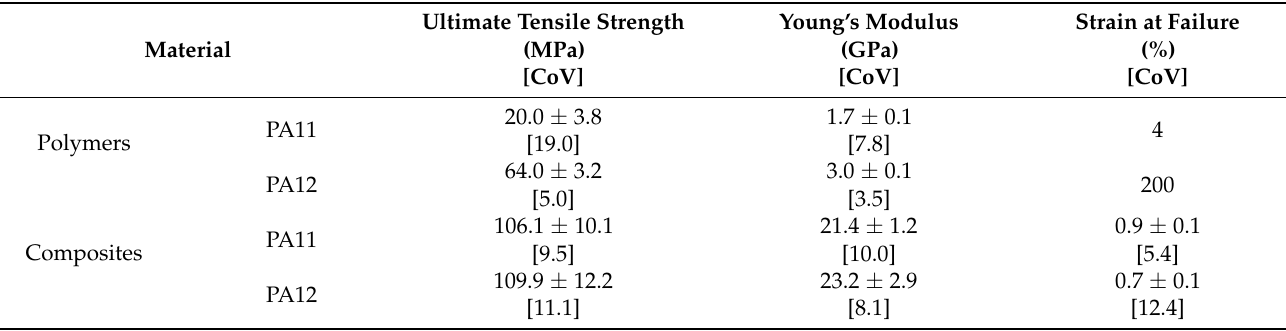
Table 5. Tensile properties of PA11, PA12, and the composites manufactured with both polyamides. Tensile properties of PA11 and PA12 are reported in